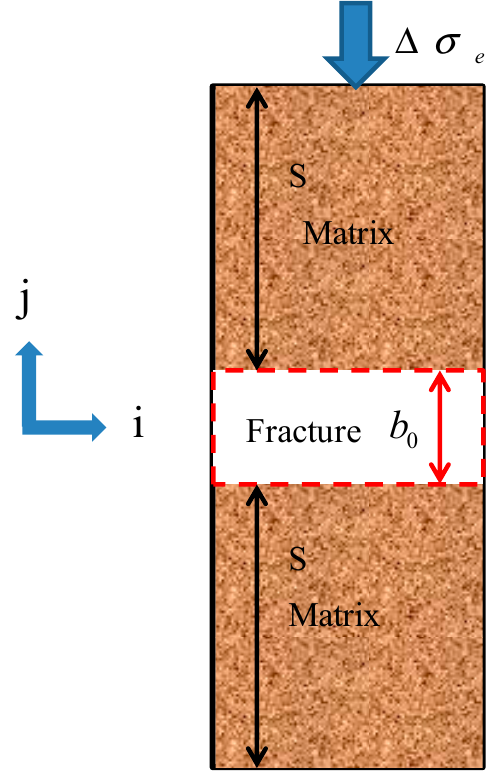
Figure 5. Deformation of fractured shale element.